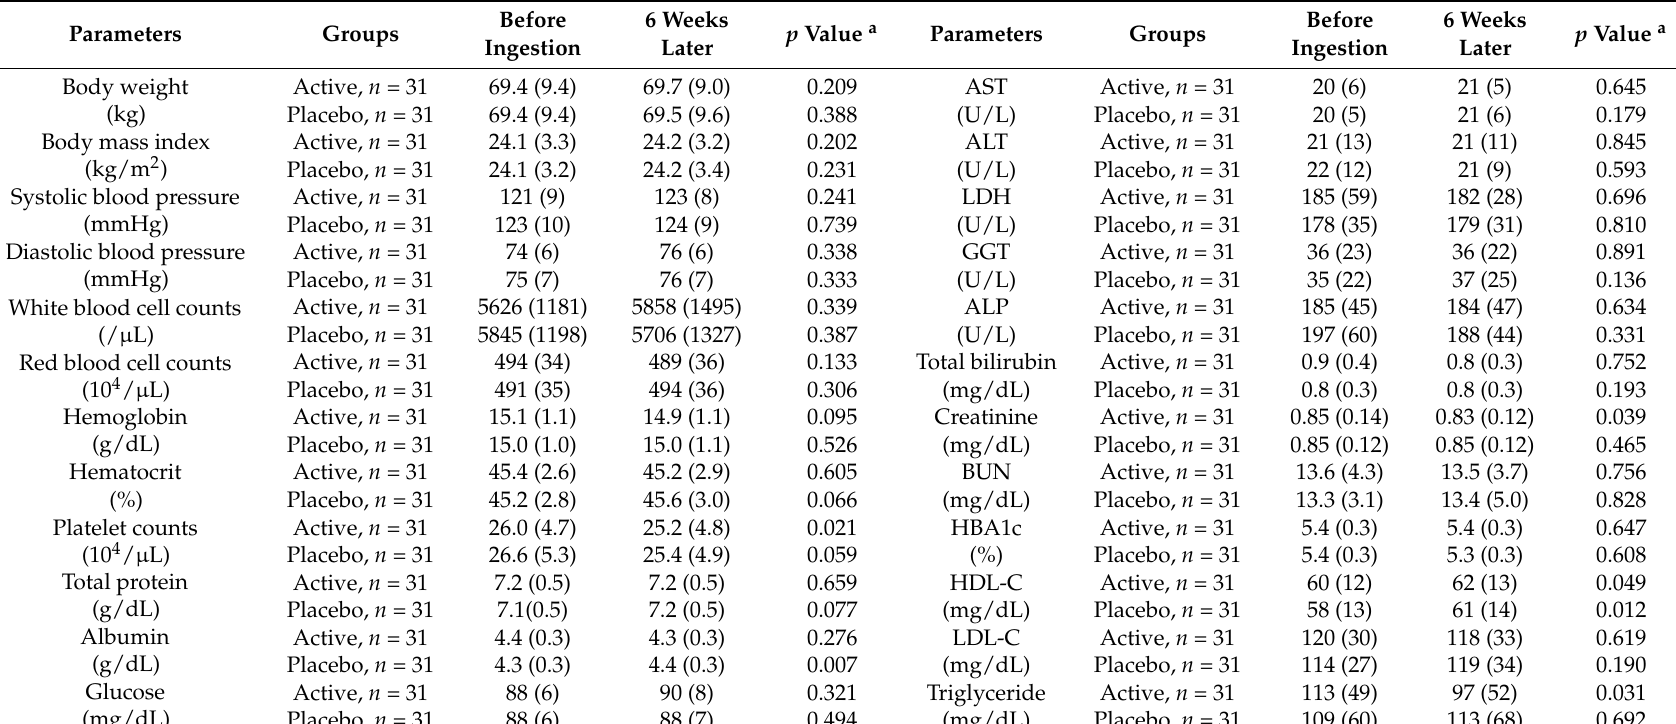
Table 5. Changes in clinical serum parameters in active and placebo